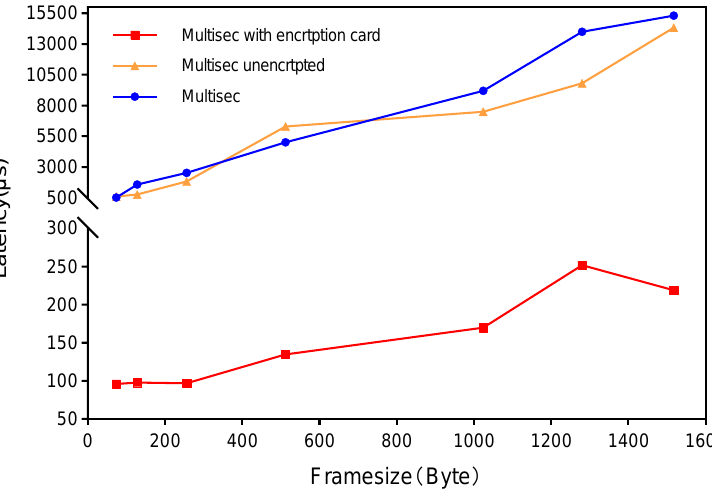
Figure 14. Latency